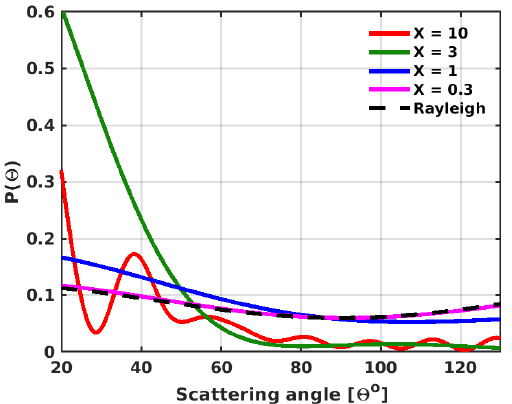
Figure 5. Mie phase functions of a monodisperse aerosol for differ- ent values of the size parameter X derived with a refractive index of 1 . 45 + 0 i . The increasing asymmetry and complexity (e.g., for X = 10) of the phase functions with increasing X are due to the use of a monodisperse aerosol. The oscillations observed are damped when the phase functions are computed for an ensemble of aerosols that are assumed to have a UMLN or gamma distribution. The phase functions are shown for the range of scattering angles that are ob- served by OMPS, SCIAMACHY, and